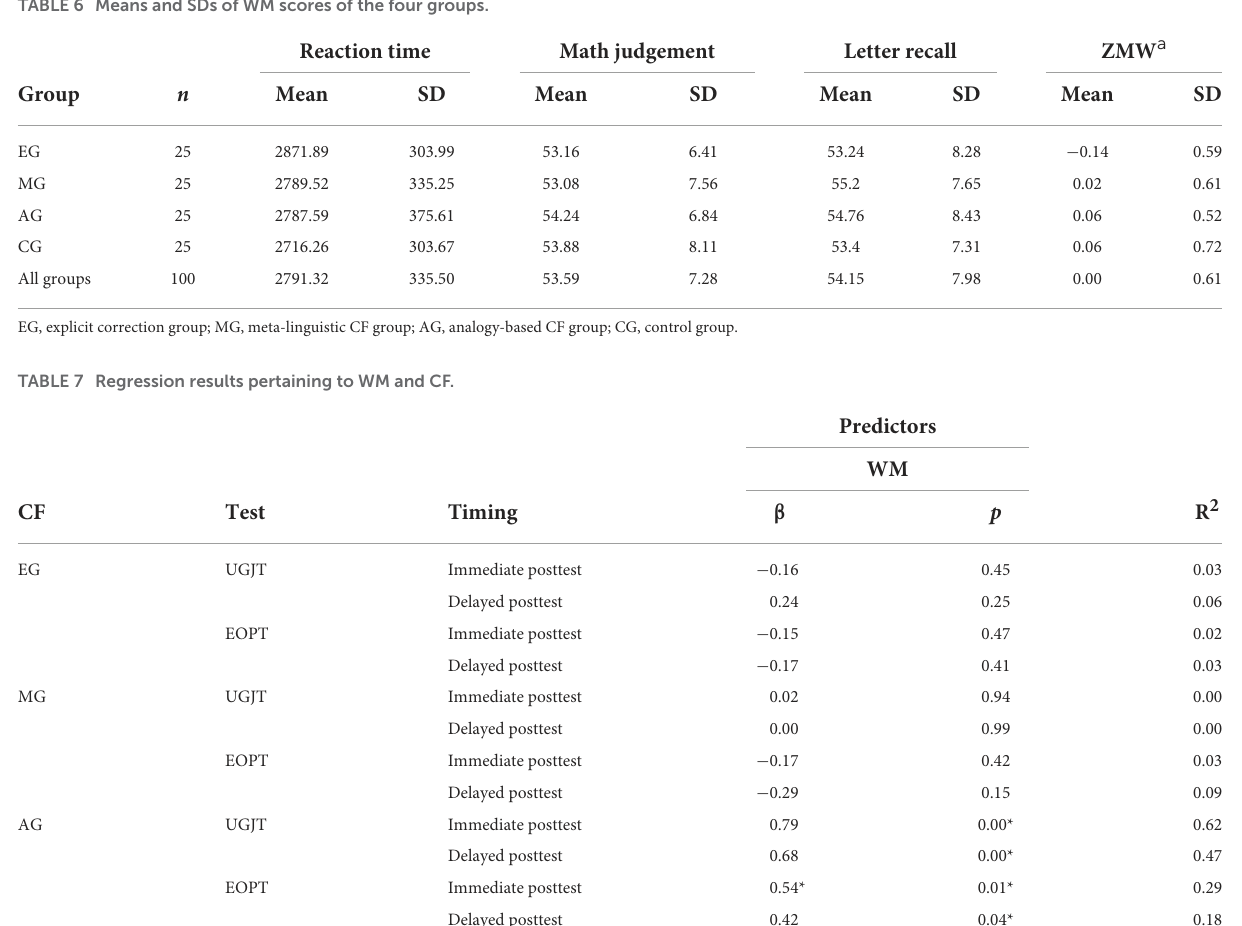
TABLE 6 Means and SDs of WM scores of the four groups.